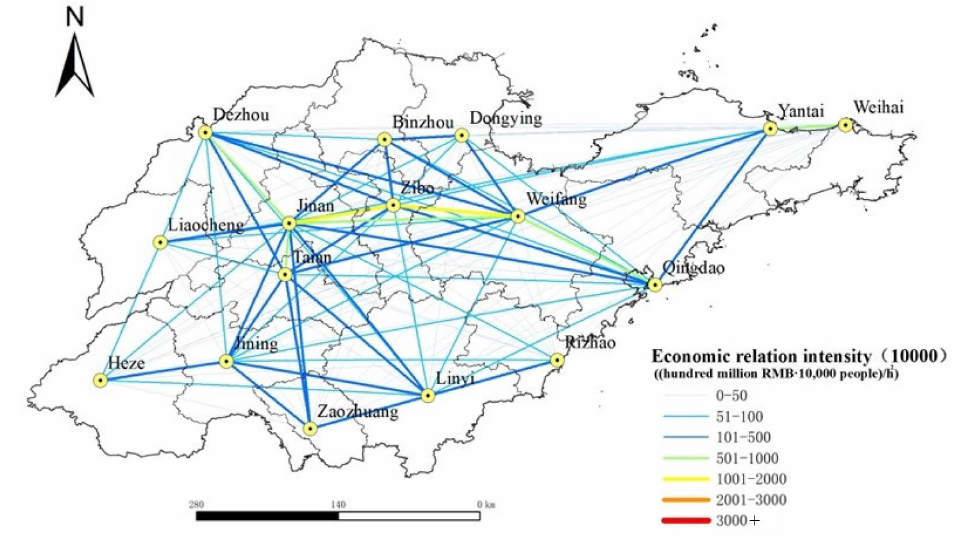
Figure 7. Urban economic relation intensity in Shandong Province, China, in 2020.